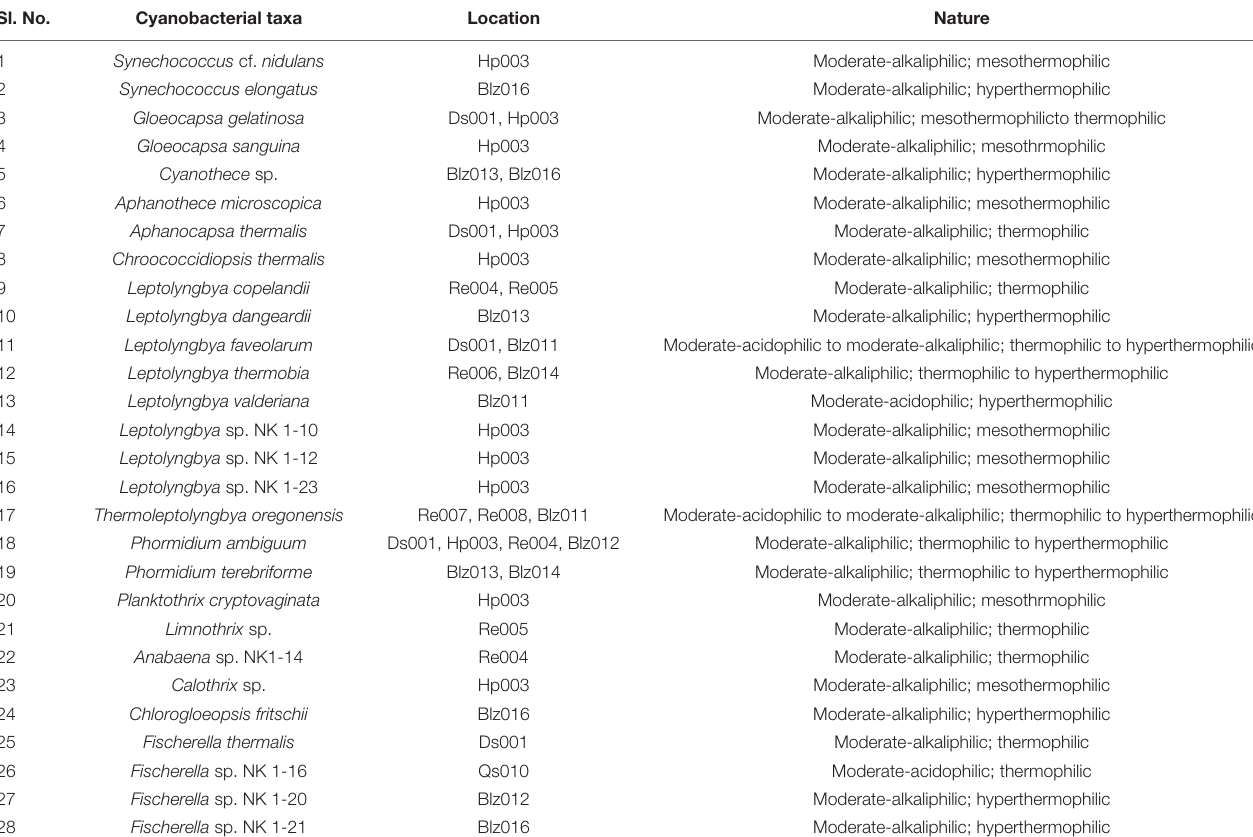
TABLE 2 | Nature of reported cyanobacteria from Yunnan hot springs based on the range of pH and temperature of sampling sites. Sl.